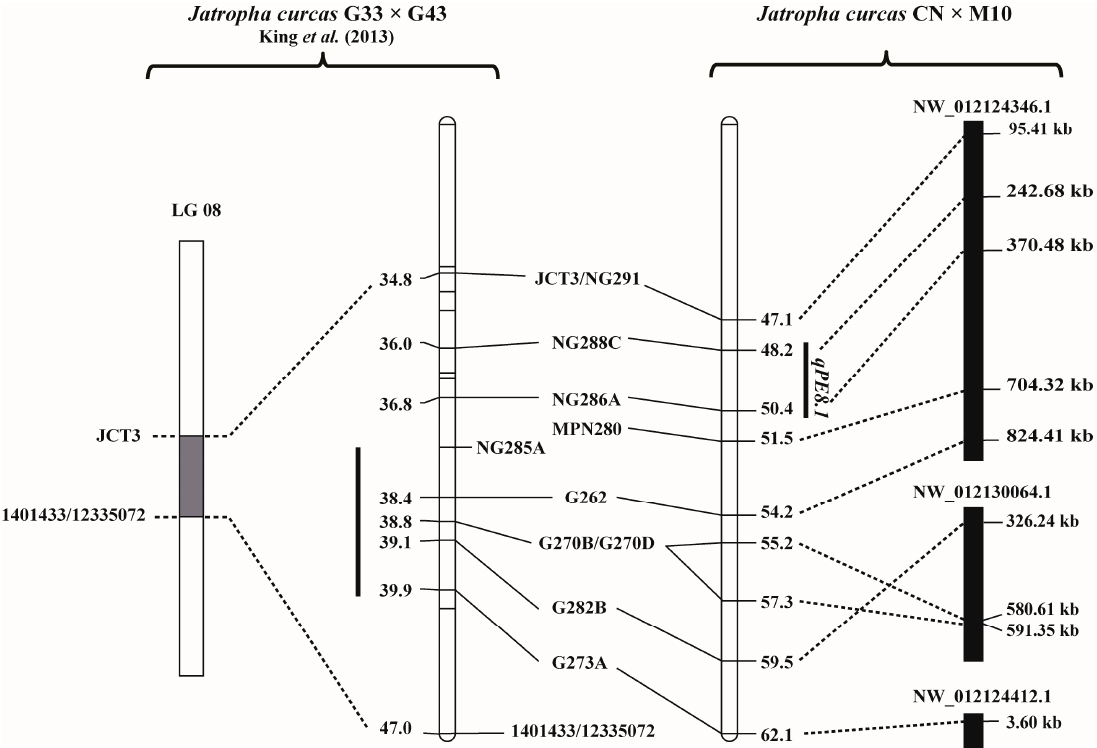
Figure 5. Comparative map illustrating the position of qPE8.1 for seed phorbol esters content in the F 2 population of Chai Nat × M10 identified in this study (right) and the location of locus controlling seed phorbol esters in the F 2 population of G33 × G43 reported by King et al. [12] (left). Lines connect common markers between the two maps. Small solid bars along the maps indicate confidence intervals of the locus detected for seed phorbol esters. The QTL for PE reported by King was initially mapped between markers JCT3 and 1401433/12335072 by considering the PE as a quantitative trait. The PE locus was then fine mapped between markers NG285A and G273A by considering PE as a qualitative trait. Three solid bars along the map of Chai Nat × M10 represent Jatropha reference sequence from Jatropha curcas Database (JCDB).